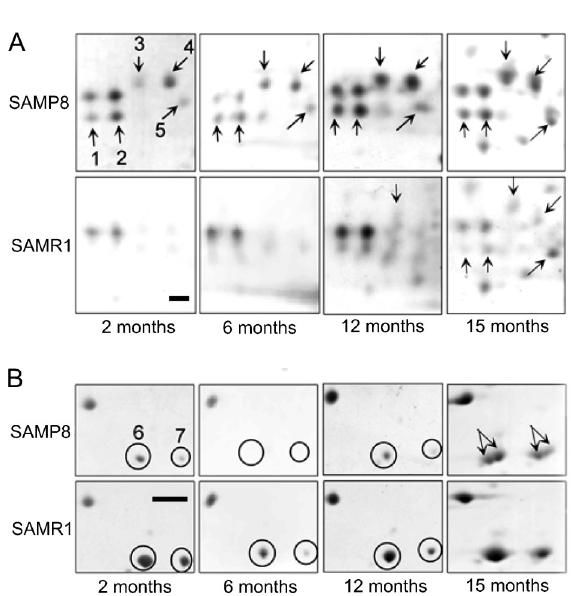
Figure 2. Enlarged 2-DE maps of 7 differentially expressed proteins inserafrommiceat 2, 6,12, and15months. A ,Spots1to5(marked with arrows) were expressed in all serum samples from SAMP8 mice and in SAMR1-15 m mice, except for a slight expression of spot 3 in SAMR1-12 m sera. Bar = 1 cm. B , Spots6 and 7 (marked with circles) were significantly down-regulated in sera from SAMP8-2 m, -6 m, and -12 m mice, and divided into 2 spots in SAMP8-15 m mouse sera (marked with arrows). Bar = 1 cm.